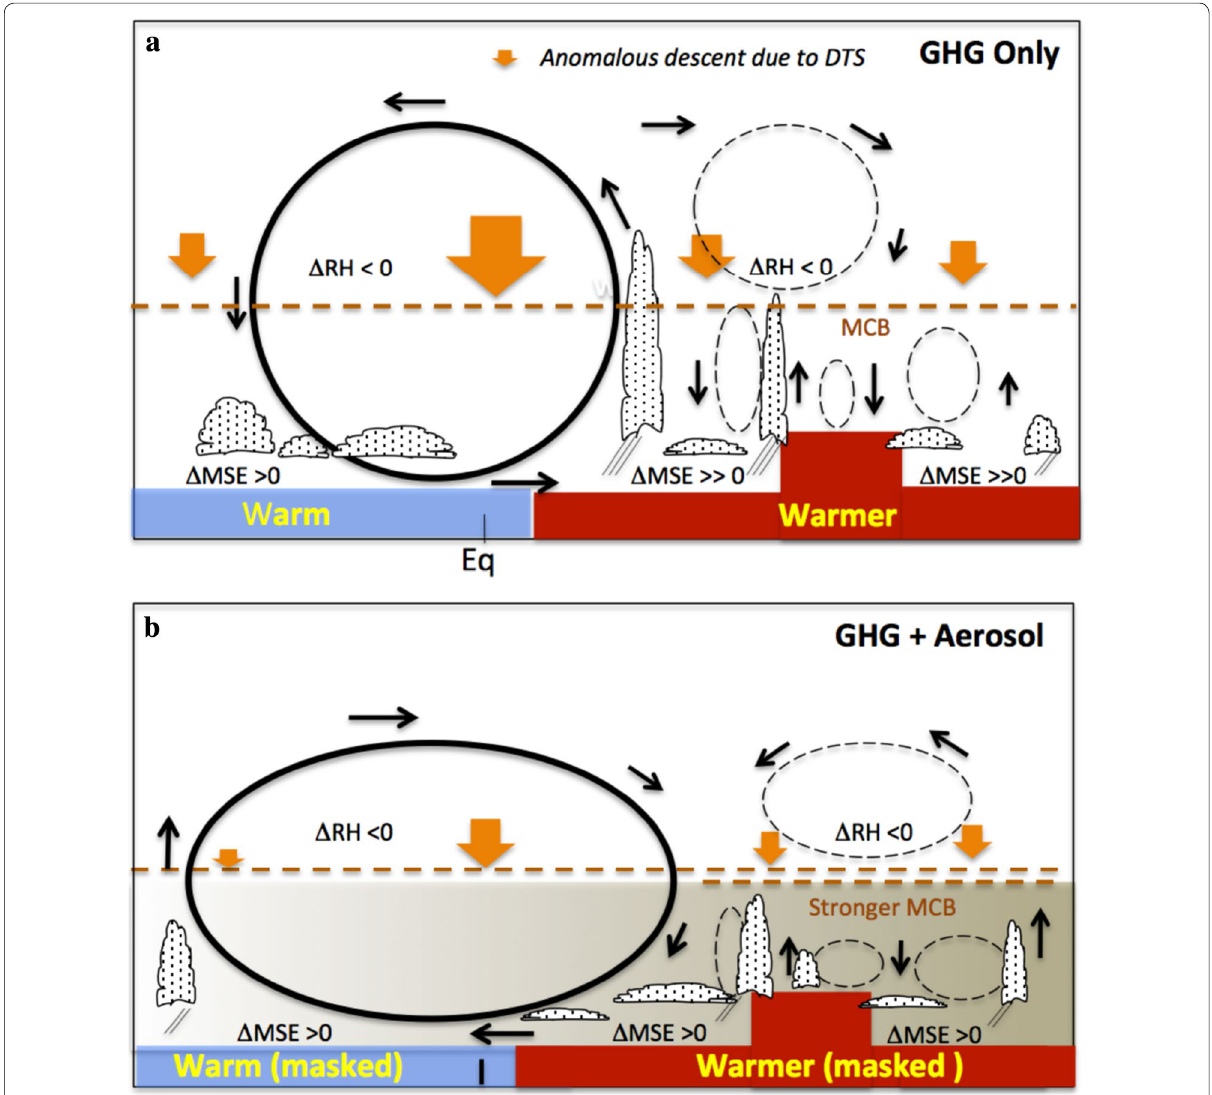
Fig. 6 Schematics showing structural changes in the Asian summer monsoon meridional circulation (MMC), rainfall and cloud processes, as a result of competing influences of enhanced low‑level moisture static energy (MSE) and the mid‑tropospheric convective barrier (MCB, denoted by dashed brown line) due to tropospheric drying (ΔRH < 0), stemming from adjustment of the large‑scale circulation to the Deep Tropical Squeeze (DTS), and regional precipitation–cloud–radiation dynamical feedback processes under ( a ) GHG warming and ( b ) combined GHG and aerosol effects. Solid circles denote major changes in the oceanic and adjacent land portion of the MMC. Dashed circles represent anomalous multi‑cellular structure over the ASM land